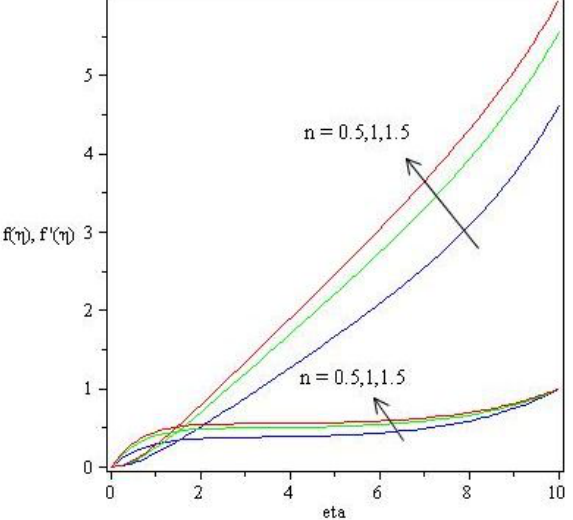
Fig. 11: Skin-friction profile for different values of λ when β = σ = 0.5